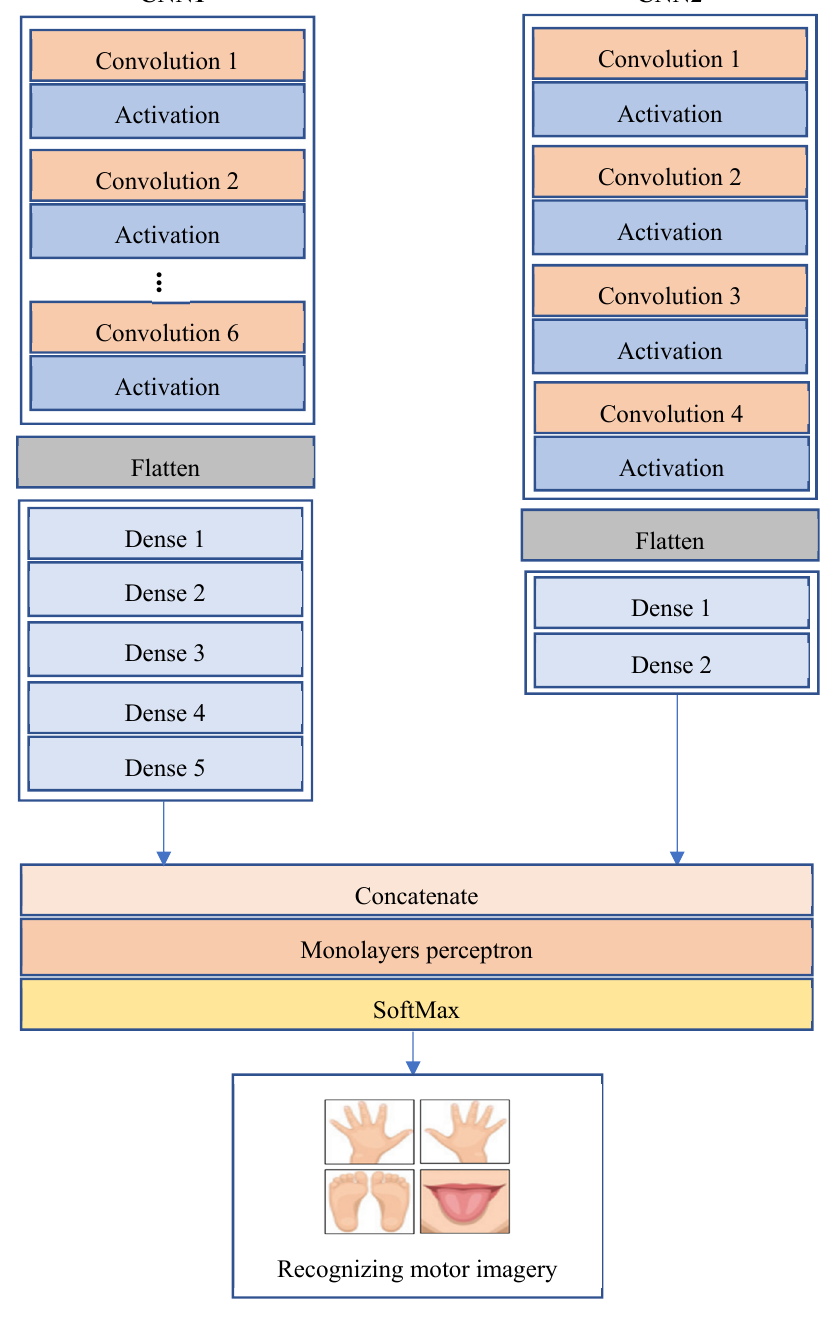
Figure 9. The proposed modified merged CNNs model.